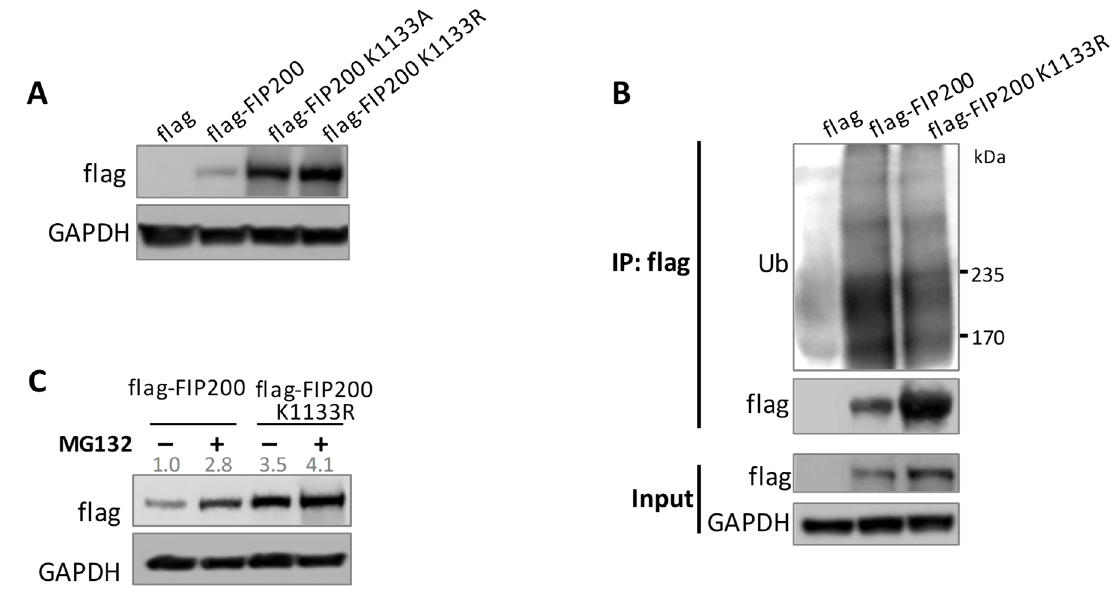
Figure 4. K1133 is critical for FIP200 protein stability. ( A ) Immunoblot of flag-FIP200 and its two mutants showed that K1133 mutations stabilized FIP200. ( B ) The ubiquitination level of the FIP200 K1133R mutant was decreased compared to wild-type FIP200. HeLa cells were transfected with His-Ub and indicated plasmids. ( C ) Immunoblot showed a more significant accumulation of flag-FIP200 compared to the K1133R mutant upon blocking protein degradation. HeLa cells were transfected with indicated plasmids. Flag-FIP200 and K1133R mutant were quantified and normalized to GAPDH.